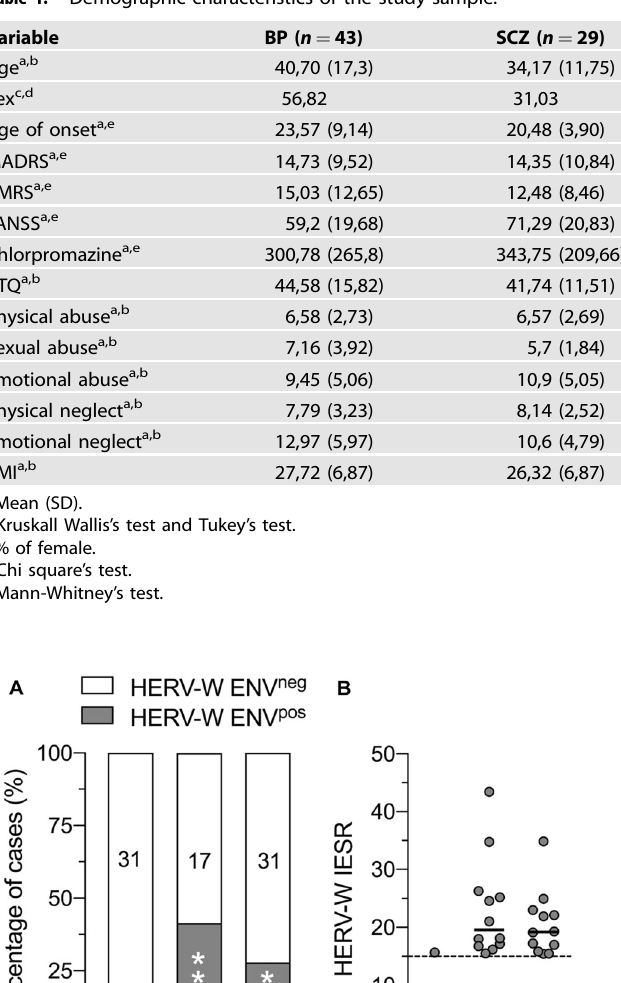
Table 1. Demographic characteristics of the study sample.